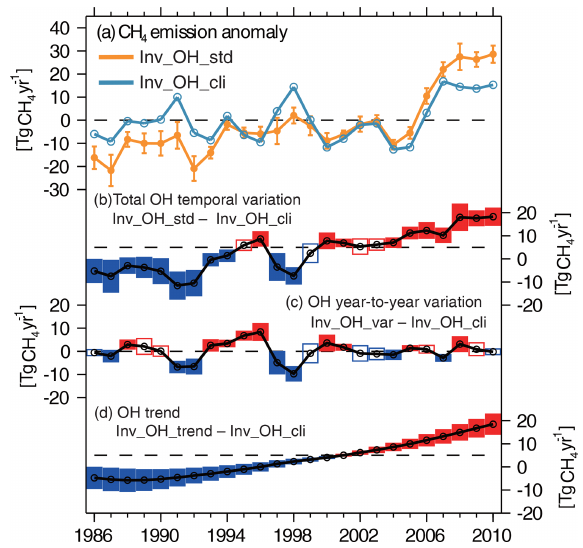
Figure 4. (a) Anomaly of global total CH 4 emissions using scaled CCMI OH fields (orange line, Inv_OH_std), and climatological OH (blue, Inv_OH_cli) estimated by a two-box model inversion. The anomalies are calculated by comparison with the climatological mean CH 4 emissions of Inv_OH_cli over 1986–2010. (b–d) Influ- ences of (b) total OH temporal variations (OH year-to-year vari- ation and trend, Inv_OH_std minus Inv_OH_cli), (c) OH year-to- year variations (Inv_OH_var minus Inv_OH_cli), and (d) OH trend (Inv_OH_trend minus Inv_OH_cli) on box-model-estimated global total CH 4 emissions. The black lines are the mean of inversion re- sults with different OH fields, and the boxes are ± 1 standard devi- ation. The boxes with filled blue and red show OH leads to statisti- cally significant ( P < 0.05) differences between the two